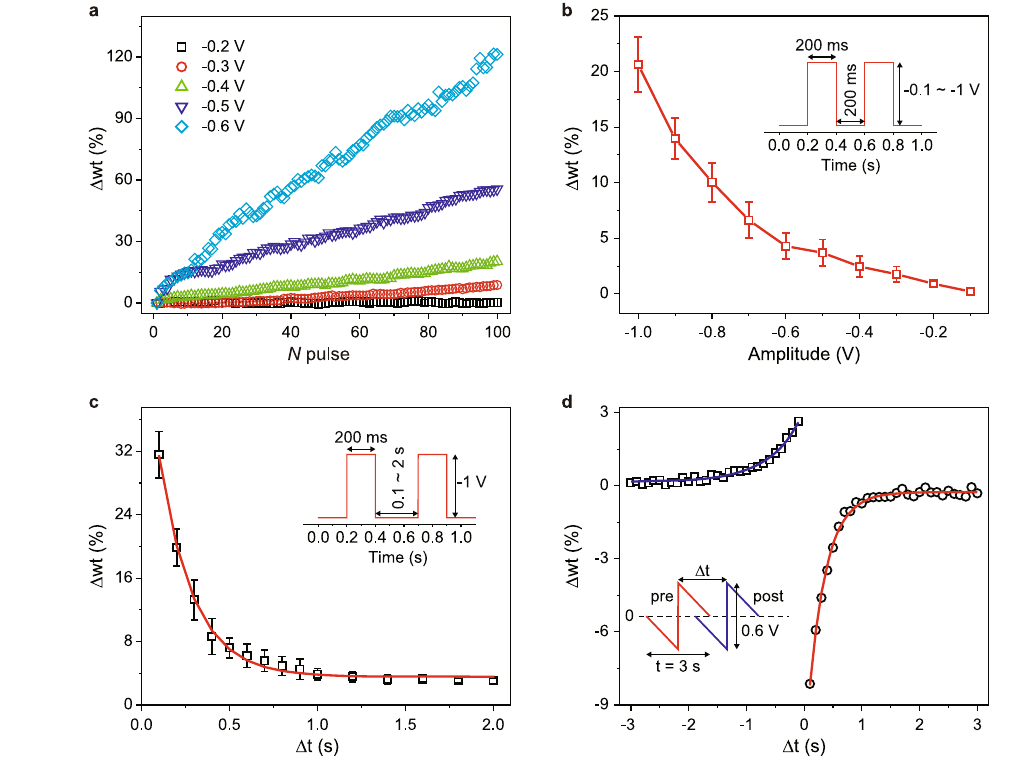
Fig. 4 | Synaptic plasticity characterization. a Synaptic weight change ( Δ wt) as a function of the number of potentiation pulses under different pulse amplitudes. The pulse width and time interval are 200ms. Paired pulse behavior of molecular synapse by changing the pulse amplitude b (time interval, 200ms), and time interval c (amplitude, − 1V).Thewidthofthepulseis200ms.Theredlinein( b )isa guideline of the dependent tendency while the red line in ( c ) shows exponential